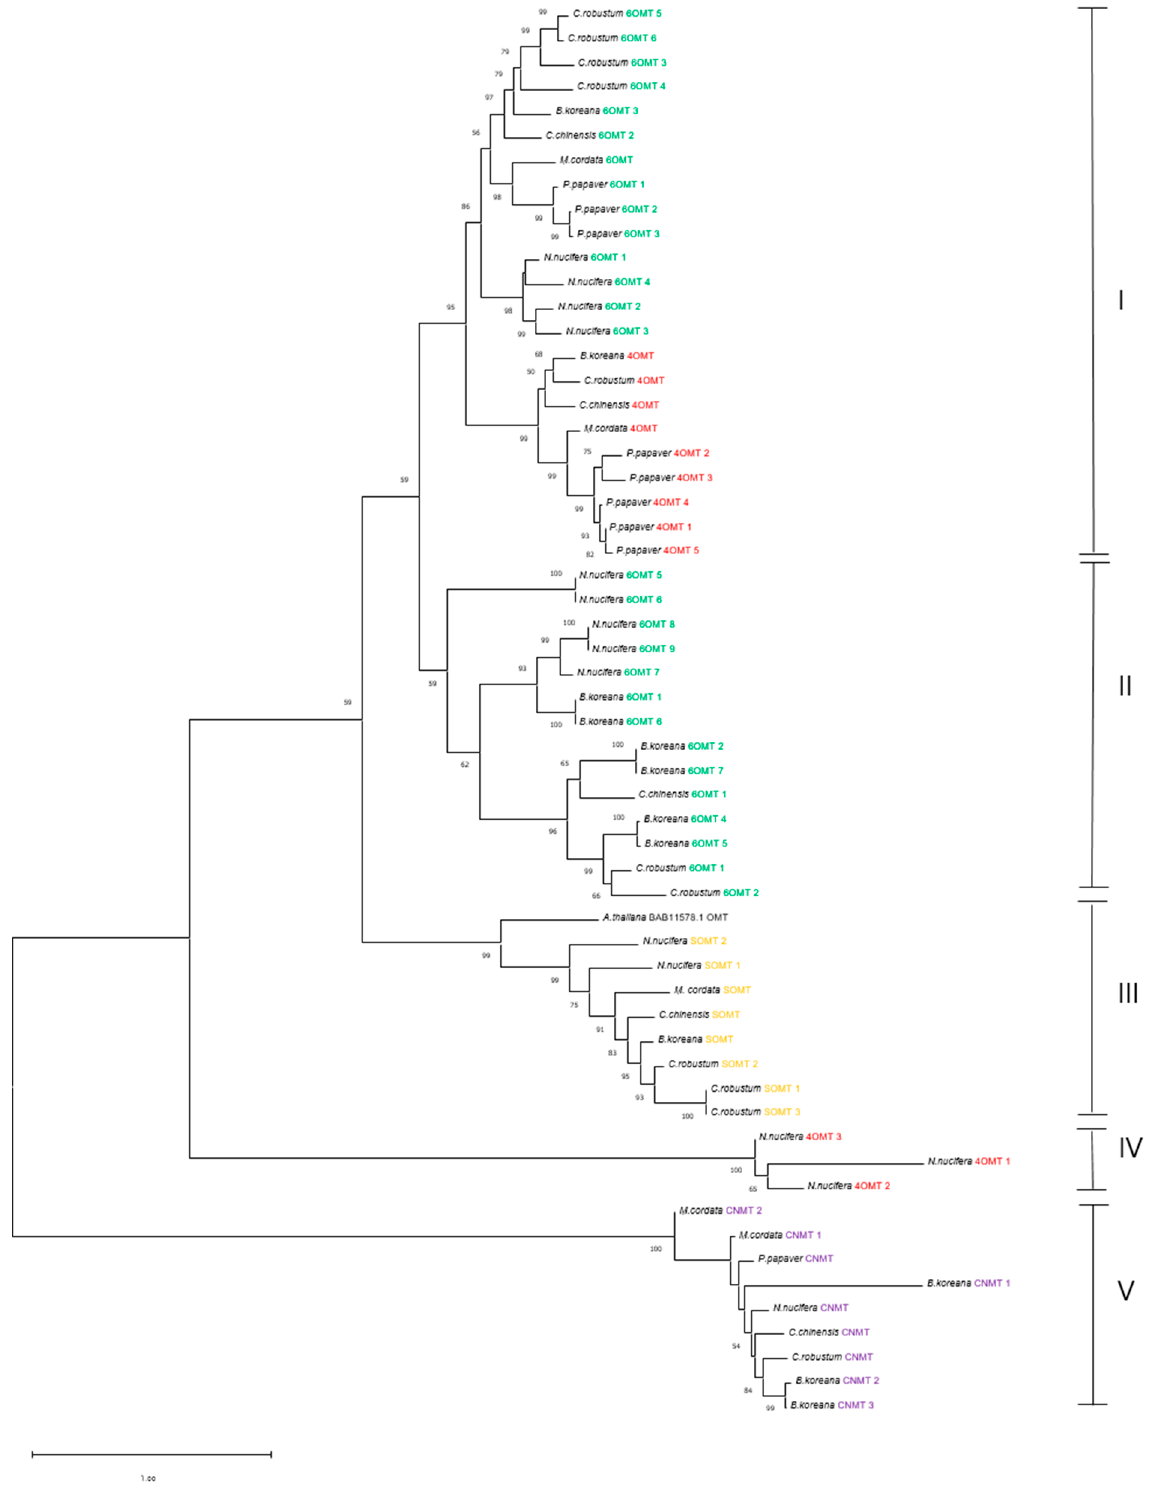
Figure 7. Phylogenetic tree of methyltransferases. Species— B. lyceum : Berberis lyceum ; B. koreana: Berberis koreana ; C. chinensis : Coptis chinensis ; C. robustum : Caulophyllum robustum ; E. californica : Eschscholzia californica ; M. cordata : Macleaya cordata ; N. nucifera : Nelumbo nucifera ; T. flavum : Thalictrum flavum ; P. somniferum : Papaver somniferum ; P. nudicaule : Papaver nudicaule . The scale bar represents the phylogenetic distance derived from substitution per site in the sequence. There were 184 CYP genes that fell into 31 families of CYP monooxydases in the tran- scriptomes of C. robustum (Table 4). The family was identi fi ed by the NCBI nomenclature.